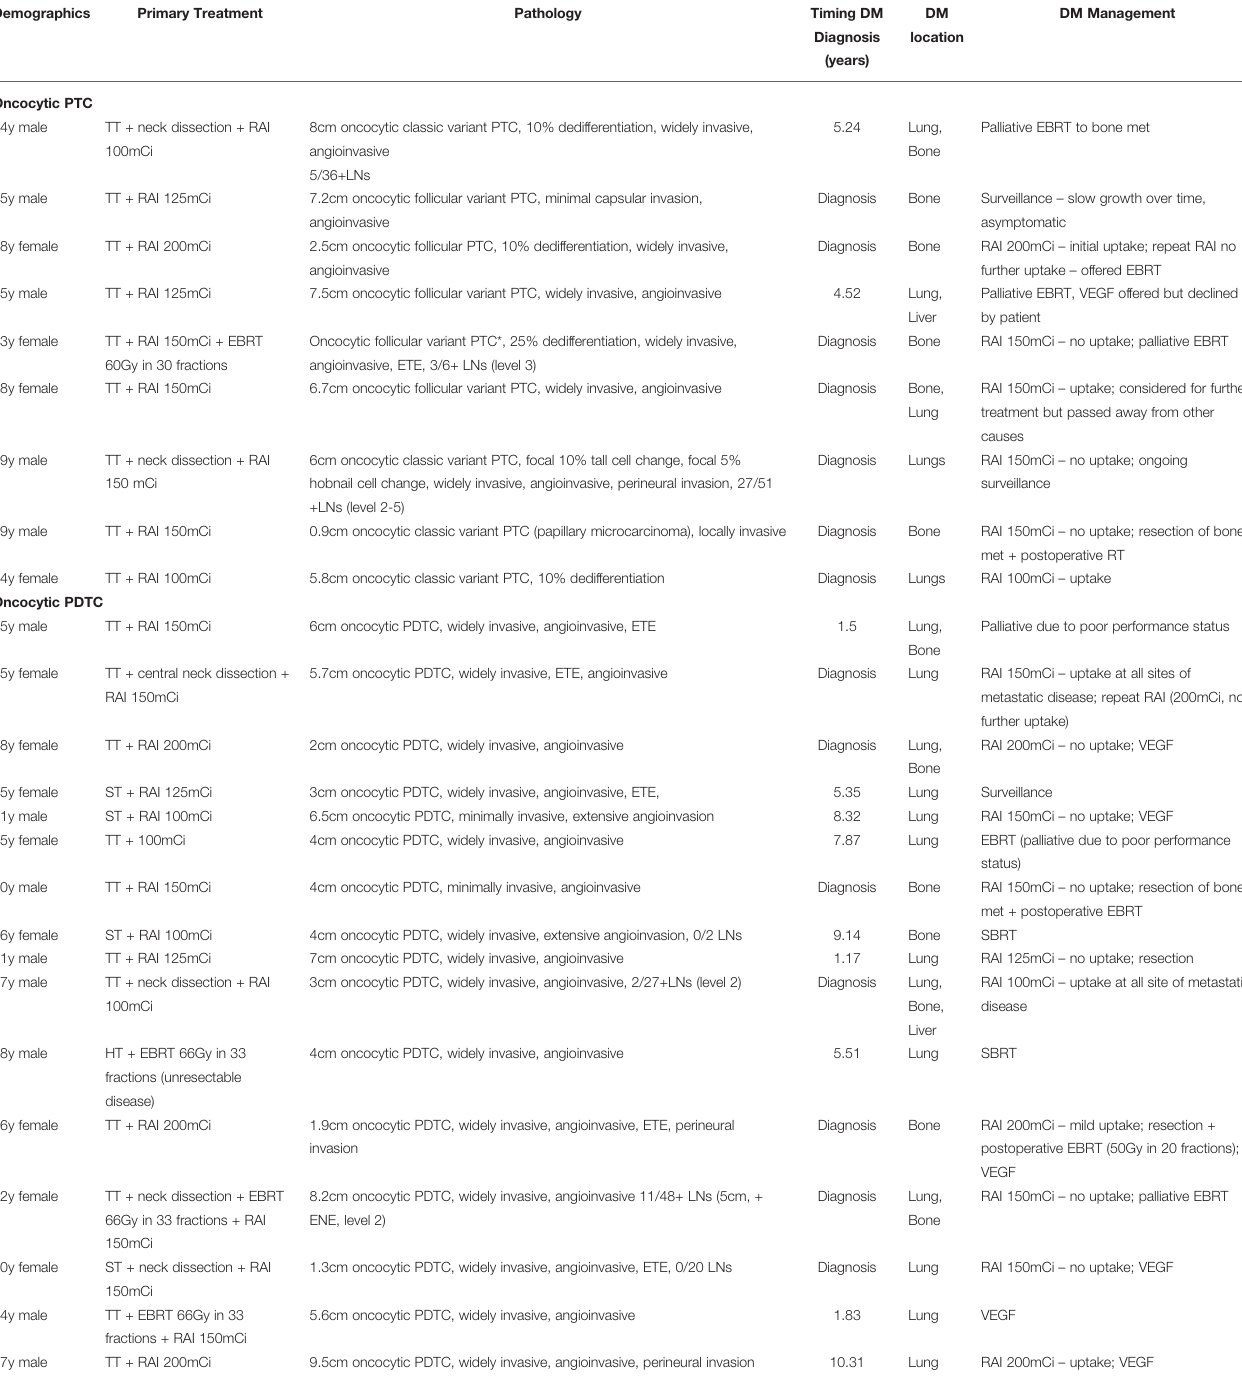
TABLE 5 | Incidence, characteristics, and management of distant metastases in patients with oncocytic papillary thyroid carcinoma and oncocytic poorly differentiated thyroid carcinoma.